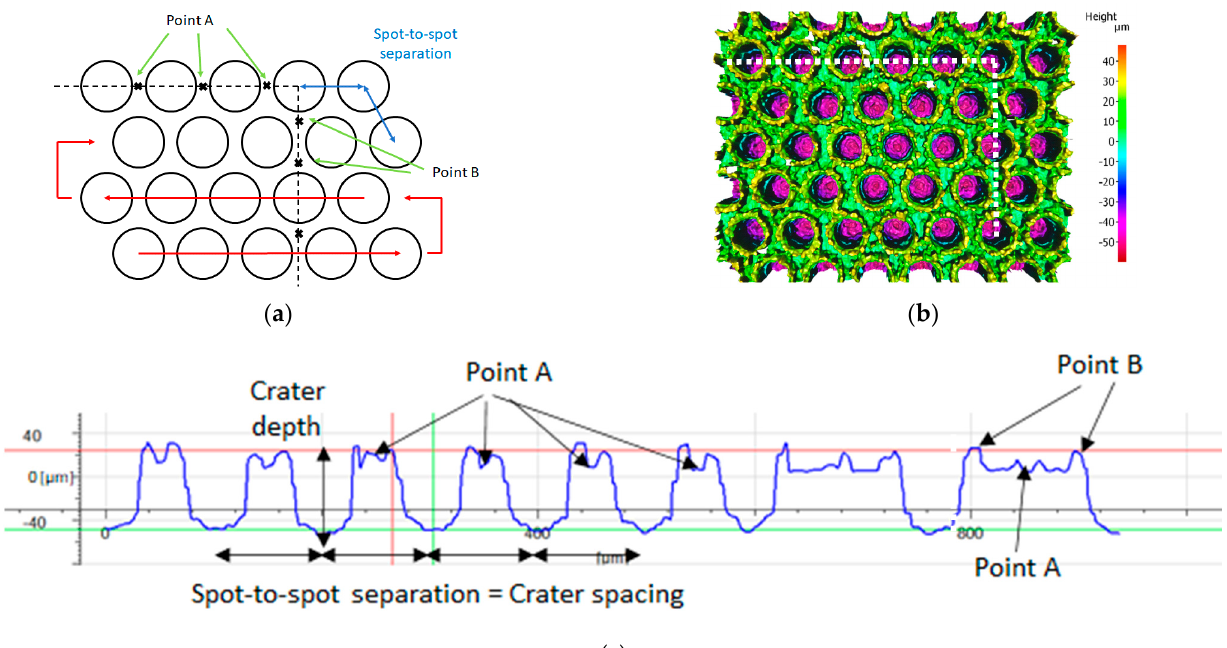
Figure 2. ( a ) Schematic of the laser scanning pattern used for high-friction surfaces. Points A and B are critical when considering surface uniformity. ( b ) Surface profile, with the dotted line indicating measurement of cross-section. ( c ) Cross-section profile of the surface with the key parameters. The first part of the profile is in the x-direction, and the second part of the profile is in the y-direction, as indicated by the dotted line.